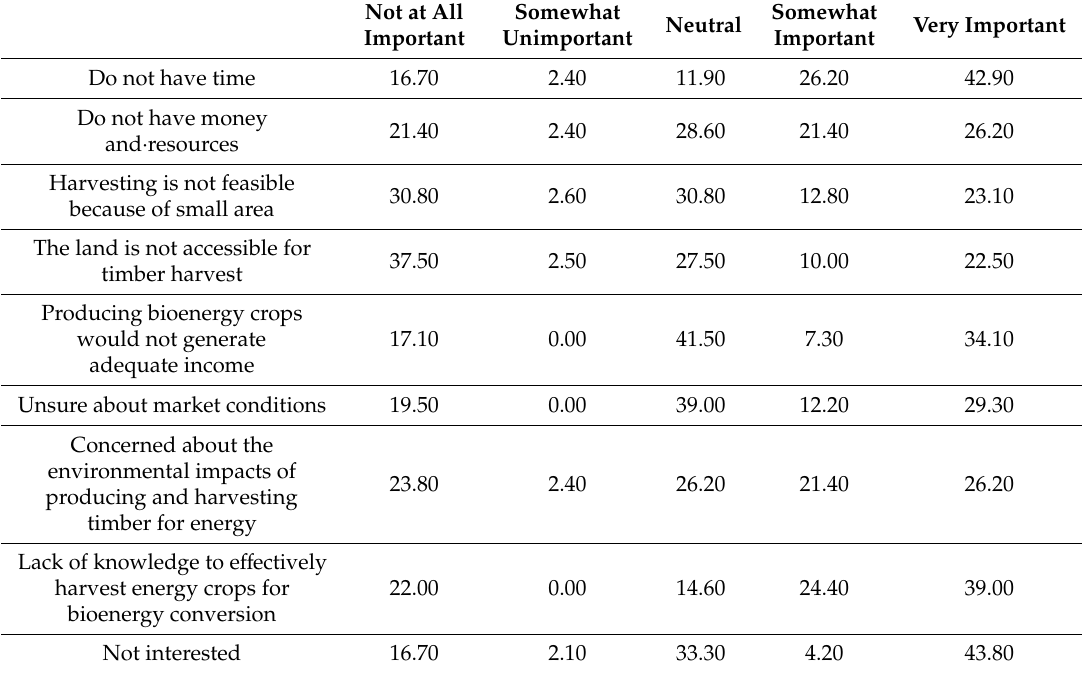
Table 2. Survey results on factors influencing landowners’ decision to not produce and harvest bioenergy crops (in %).